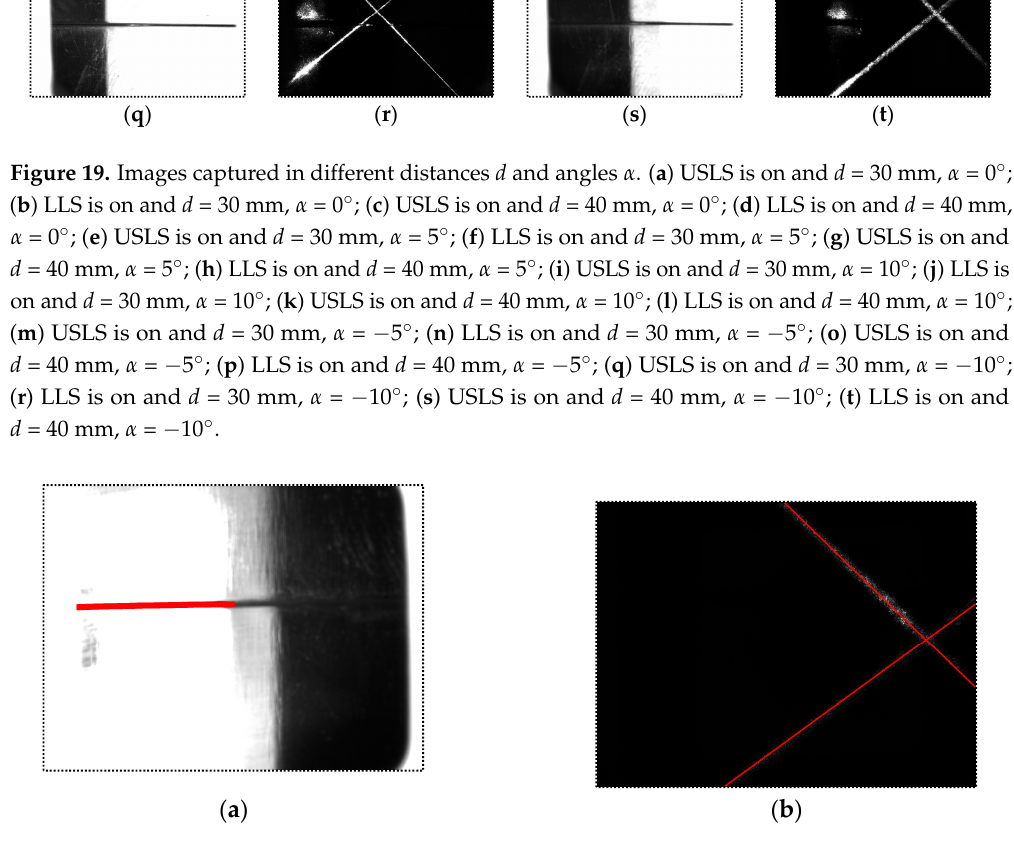
Figure 19. Images captured in different distances d and angles α . ( a ) USLS is on and d = 30 mm, α = 0°; ( b ) LLS is on and d = 30 mm, α = 0°; ( c ) USLS is on and d = 40 mm, α = 0°; ( d ) LLS is on and d = 40 mm,